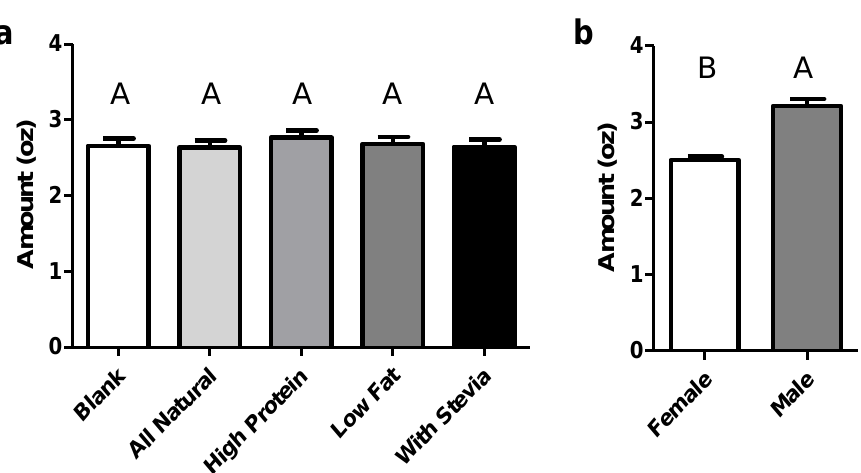
Figure 3. Ideal amount of consumption by label ( A ) and sex ( B ). Y-axis denotes ounces, with panelists advised a usual serving is 4 oz. Letters denote significant differences. Bars denote mean plus standard error.